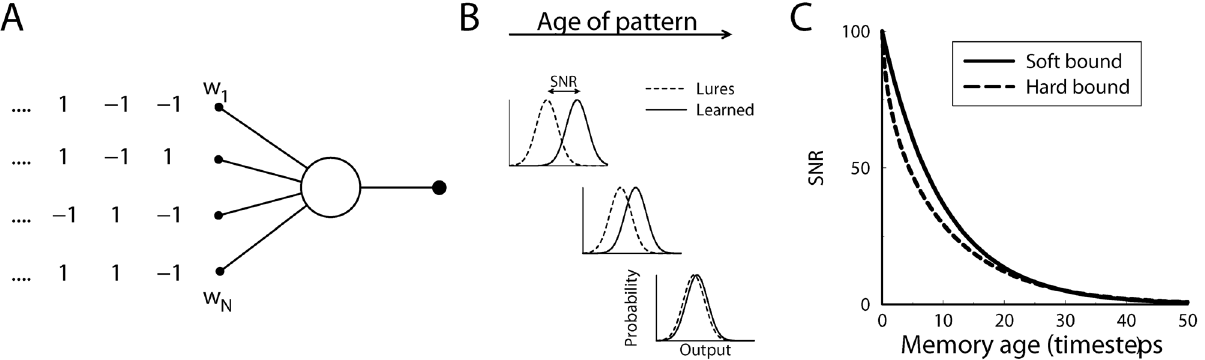
Figure 1. Diagram of the single neuron recognition task. A) A neuron receives binary pattern inputs. At each time-step a new pattern is presented and the weights are updated according to the input value. The neuron’s output equals the weighted sum of the inputs. B) The neuron has to remember the presented patterns. When tested, learned patterns lead to a larger output (solid curve) than lures (dashed curve). As the memory of the pattern ages and is overwritten by new patterns, the output of the neuron in response to the pattern becomes less distinct and the signal-to- noise ratio decays. The performance is measured by the signal-to-noise ratio, a measure of the distance between the two output distributions. C) The decay of the signal-to-noise ratio for soft-bound and hard-bound plasticity rules as a function of the age of the pattern. The synaptic updates were set so that both rules led to an initial SNR of 100 right after the pattern was presented ( a ~ 0 : 1 , N ~ 1000 ). For both plasticity rules the SNR decays, but it decays slower for soft-bound